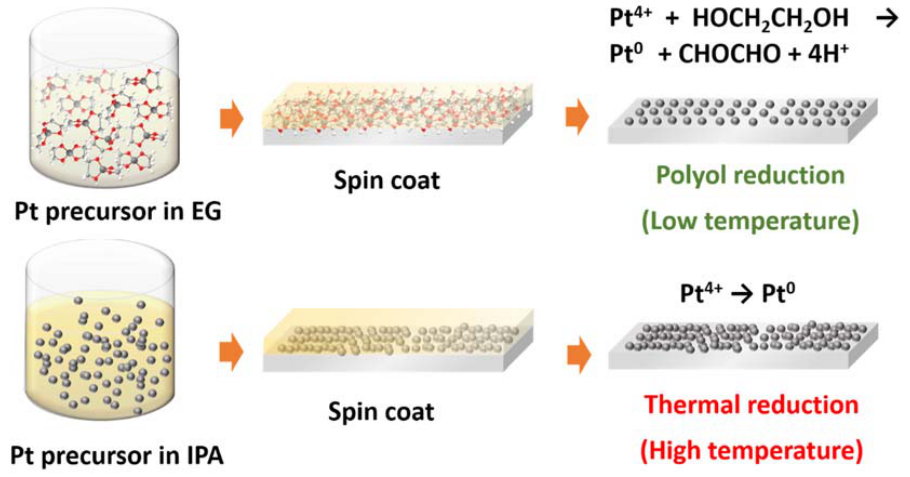
Figure 1. Schematic diagram of counter electrode preparation: polyol reduction (PR) and thermal decomposition (TD).